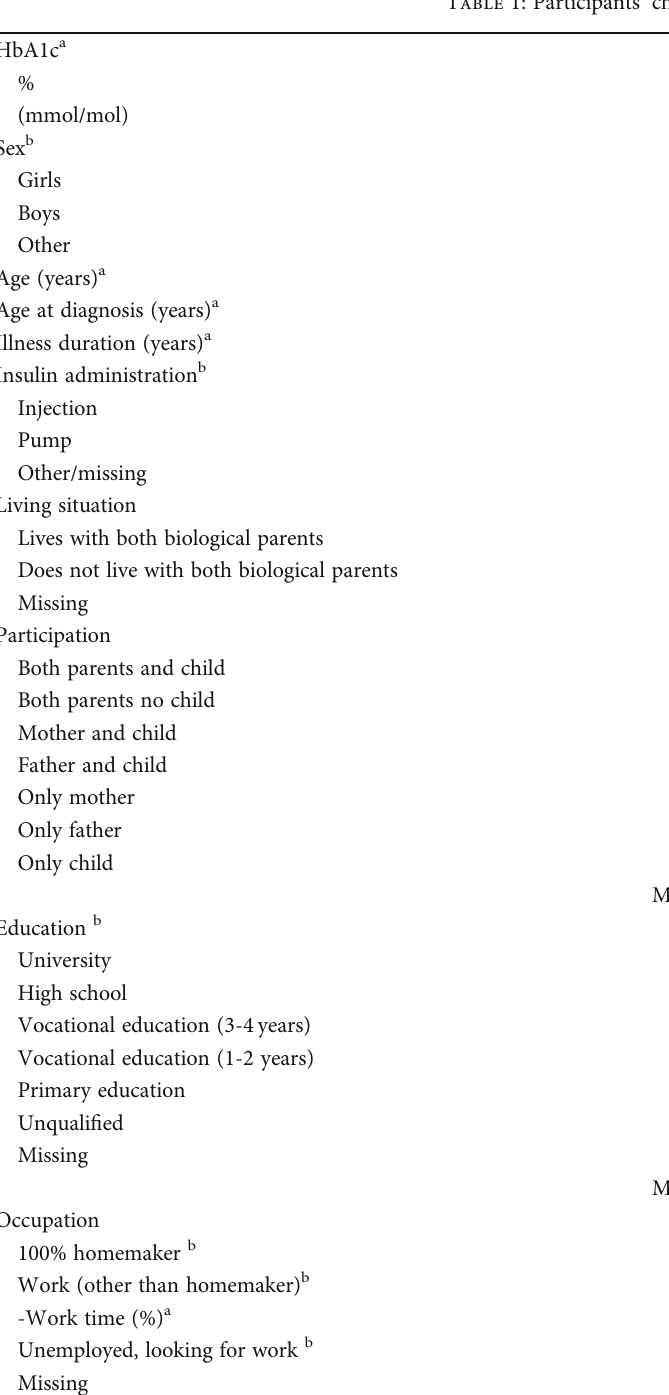
Table 1: Participants ’